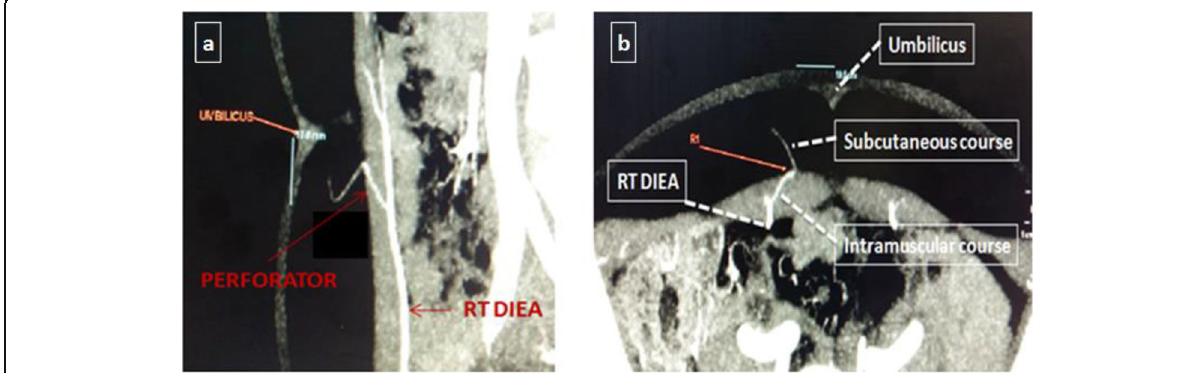
Fig. 3 Sagittal ( a ) and axial ( b ) thin maximum intensity projections of the anterior abdominal wall showing the course of the intramuscular segment and site of the piercing of the rectus by a dominant perforator in relation to the